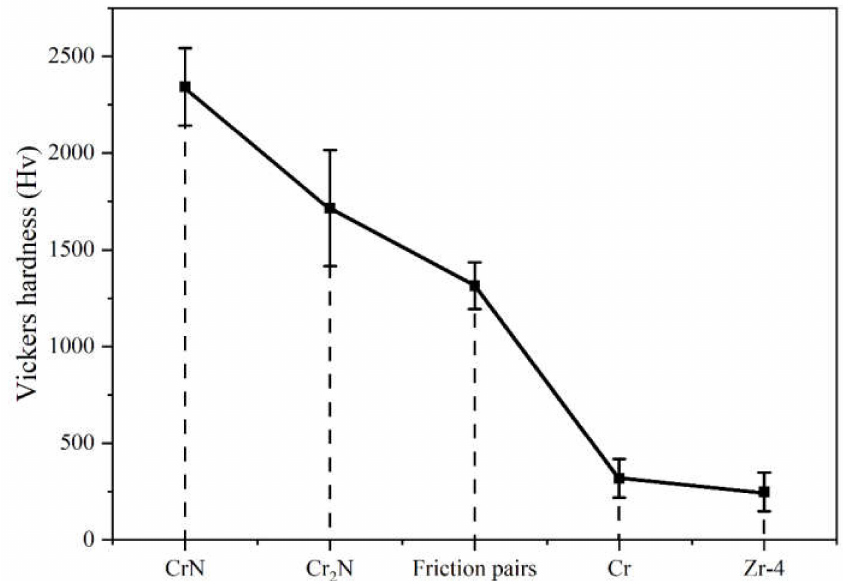
Figure 9. Results of the Vickers hardness test of the Cr-N x coatings, Zr-4 alloy, and friction pairs.